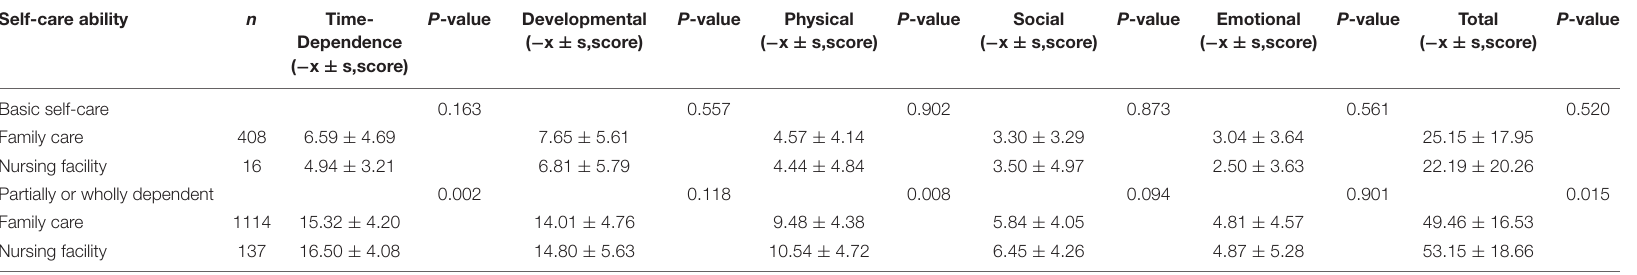
TABLE 5 | CBI scores of family members with different care status after classification according to patient self-care ability. Self-care ability